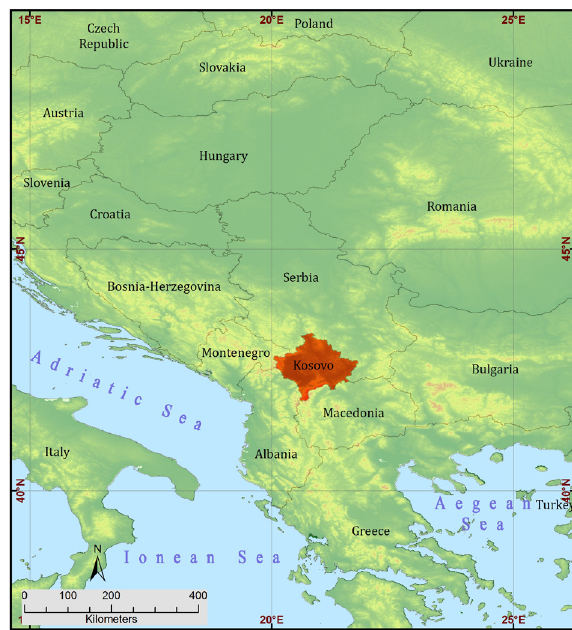
Fig. 1. Geographic position of Kosovo. Source: V. Bytyqi.